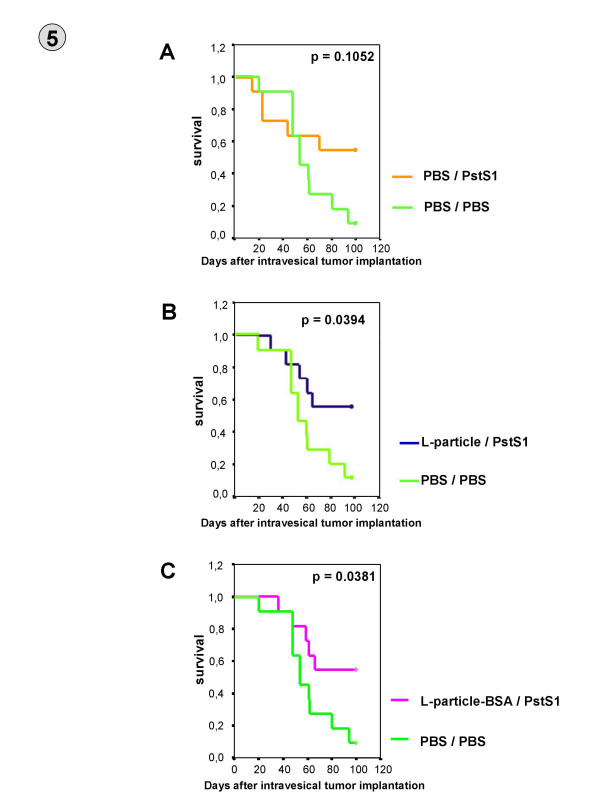
Intravesical PstS1 treatment after sensitization with PBS, PLG-particles or PLG-particles/BSA. Ten days before inoculation of MB-49 tumor cells mice were s.c. sensitized by injection of PBS (A), L-particles (B) or L-particles loaded with BSA (C). On days 1, 8, 15 and 22 after tumor challenge, mice were treated by intravesical instillation of PstS1 (A/B/C). Mice which received s.c. PBS and intravesical PBS served as control. Survival of mice was analyzed by Kaplan-Meier curve and log rank test.